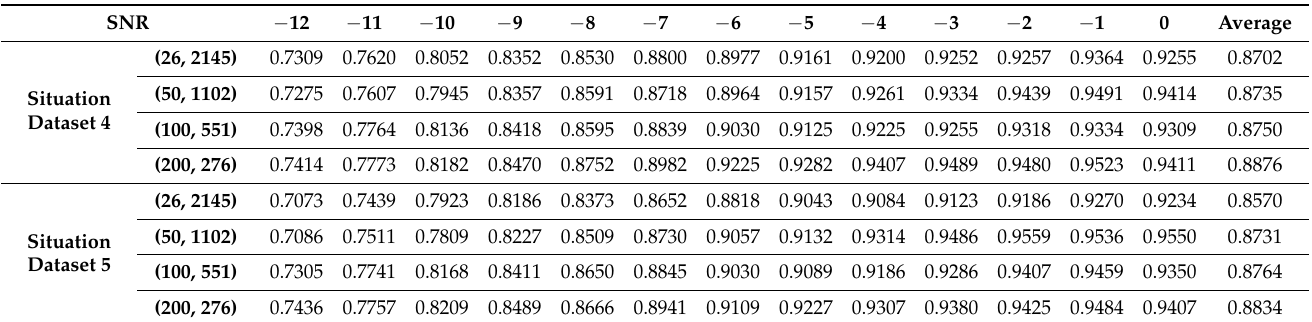
Table 8. Semi-supervised classification results with the datasets with different values of T cycle and NUM